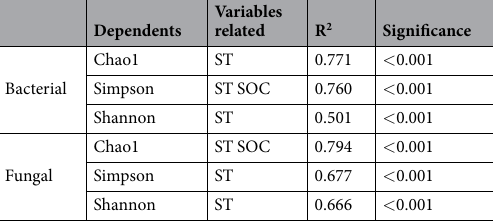
Table 3. The variables which were found by stepwise regression analysis to be correlated with bacterial and fungal α -diversity